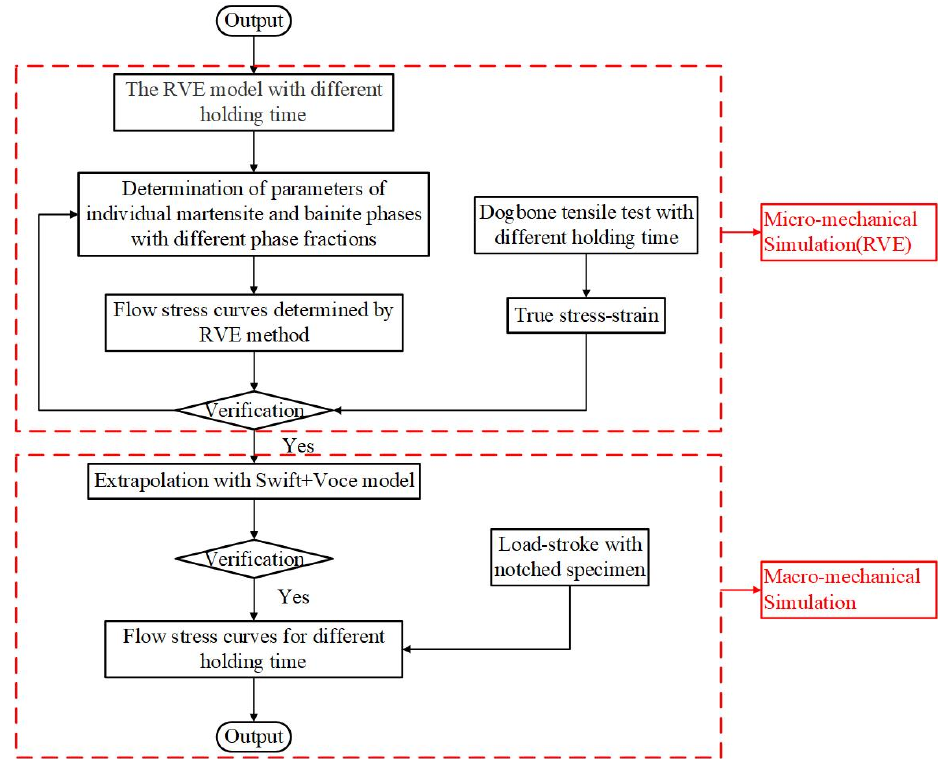
Figure 7. Flowchart to determine the stress–strain curves of bainite and martensite constituent phases.